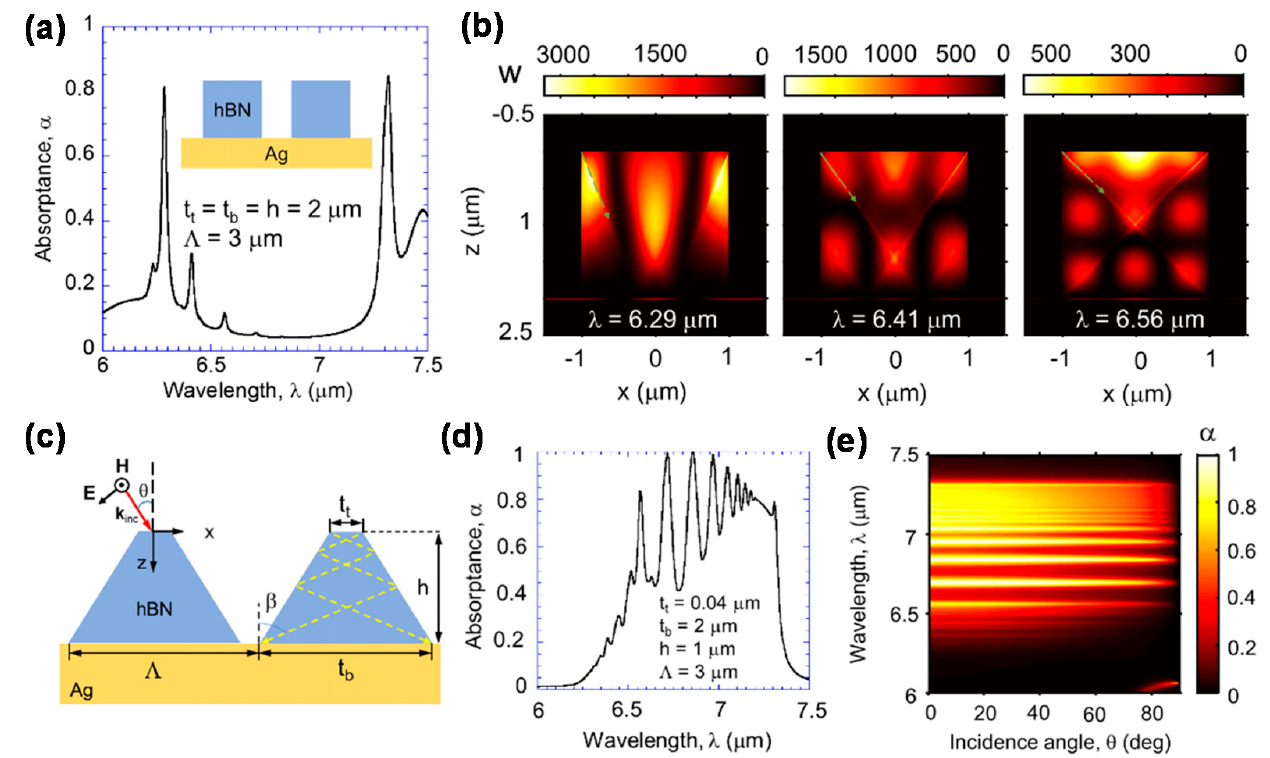
Figure 9. ( a ) Absorption spectrum of rectangular hBN-based MAE (inset: schematic) and ( b ) power dissipation contours at wavelengths of 6.29 μ m (left), 6.41 μ m (middle), and 6.56 μ m (right). ( c ) Schematic of trapezoidal hBN, ( d ) absorption spectrum, and ( e ) absorption as a function of the inci- dent angle and wavelength. Figures were adapted with permission from [78]. Copyright 2017 Op- tica.